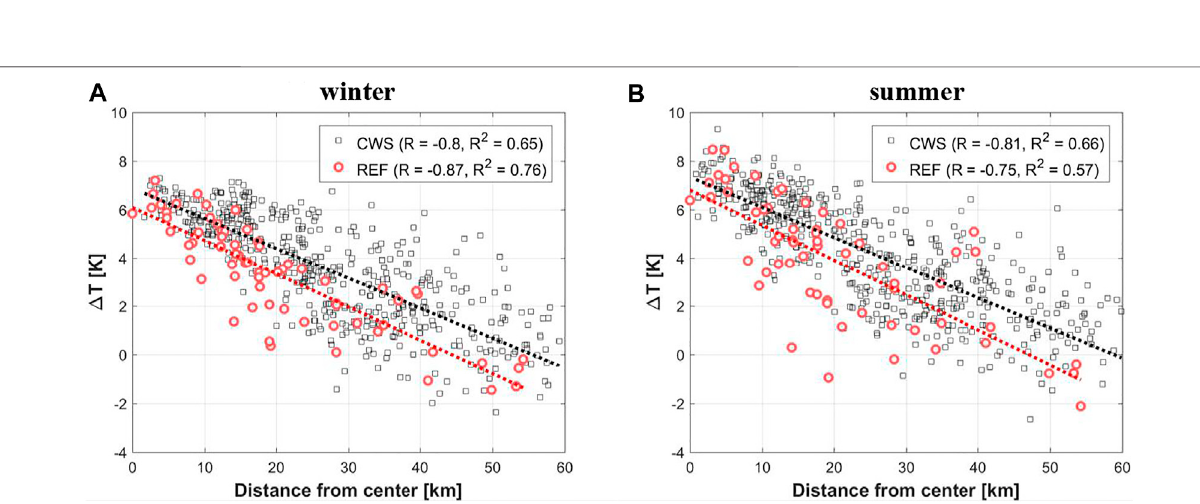
Frontiers in Environmental Science |